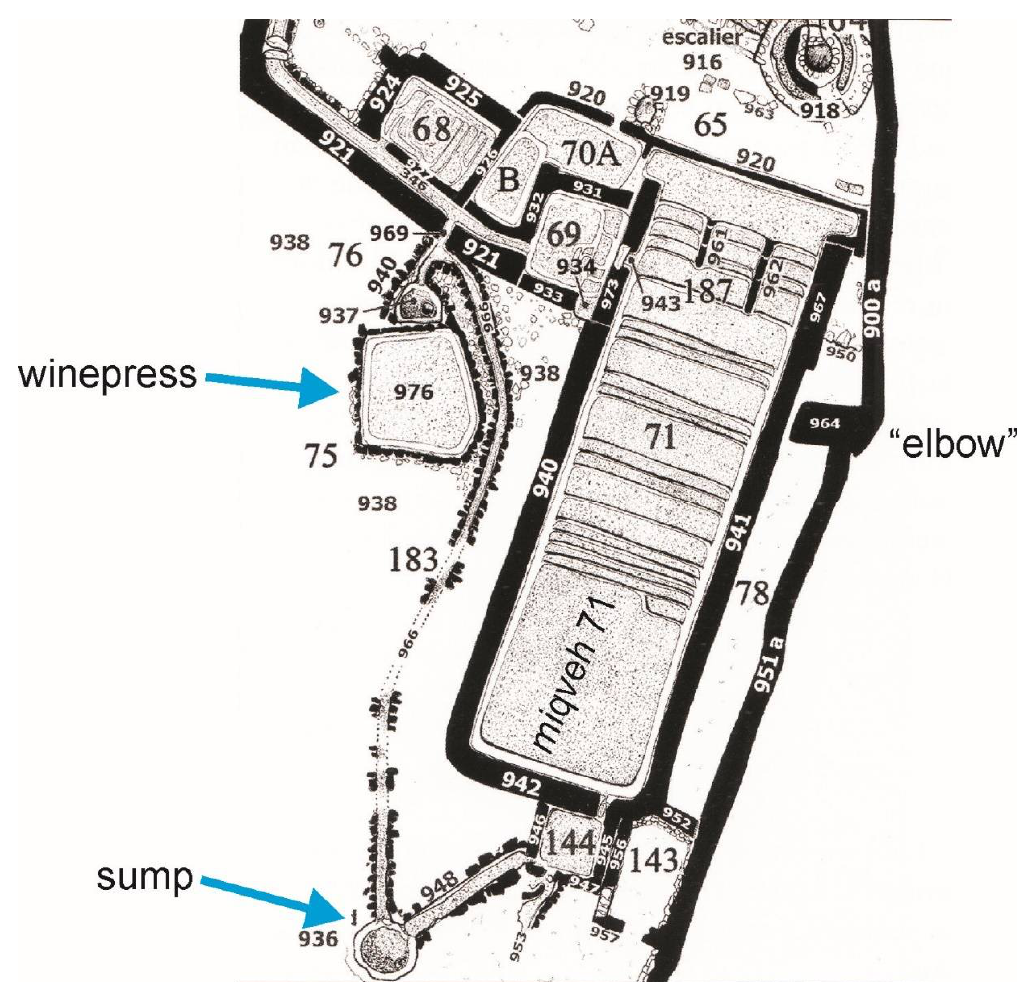
Figure 5. Based on Humbert and Chambon 2016.